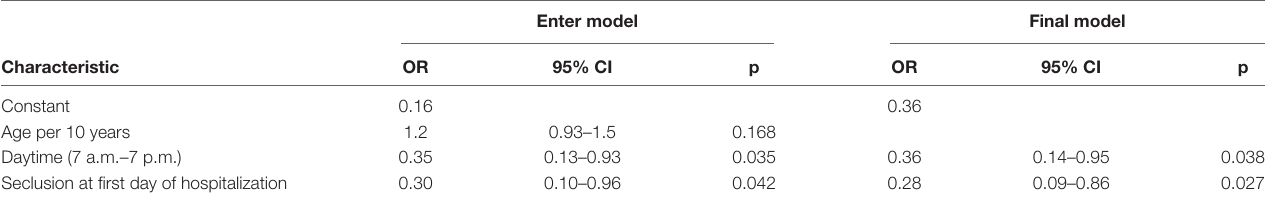
TABLE 2 | Multivariable logistic regression model of differentiating characteristics between seclusion with and without preceding aggression, n = 163. Enter model Final